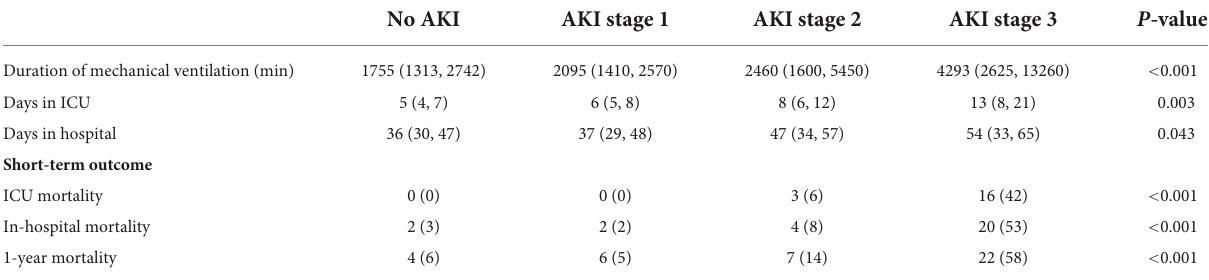
TABLE 4 The effects of AKI on the posttransplant duration of mechanical ventilation, hospitalization, and short-term outcome. No AKI AKI stage 1 AKI stage 2 AKI stage 3 Duration of mechanical ventilation (min)